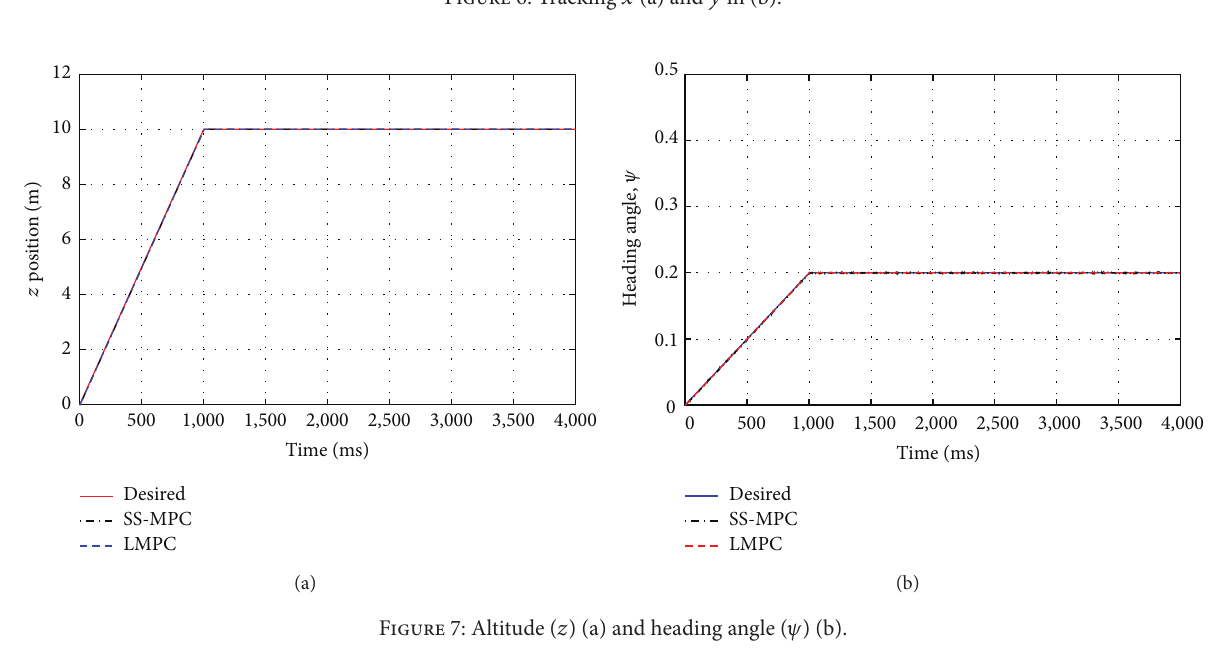
Figure 7: Altitude ( 𝑧 ) (a) and heading angle ( 𝜓 ) (b).